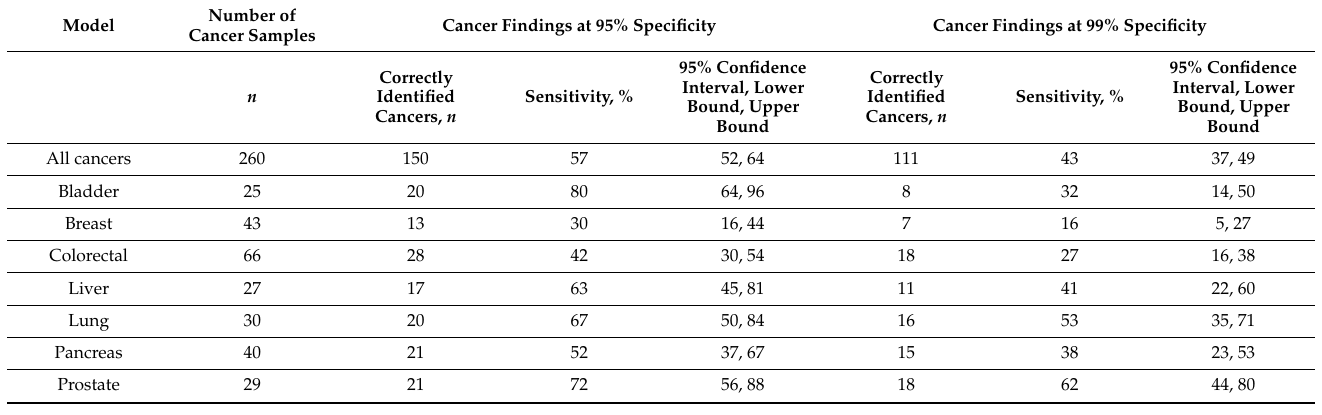
Table 2. Number of cancer samples and cancer finding/sensitivities at 95% and 99% specificity.